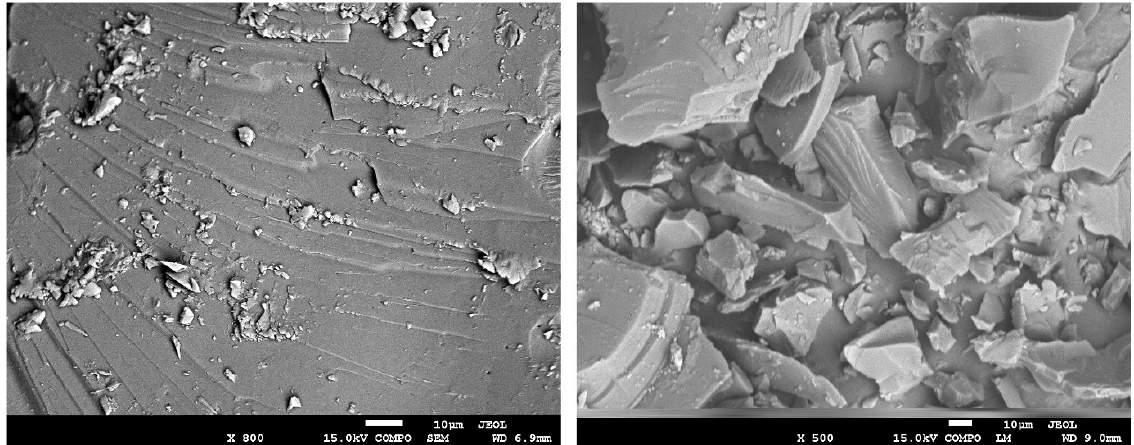
Figure 1. SEM images of the surface of sample P1.